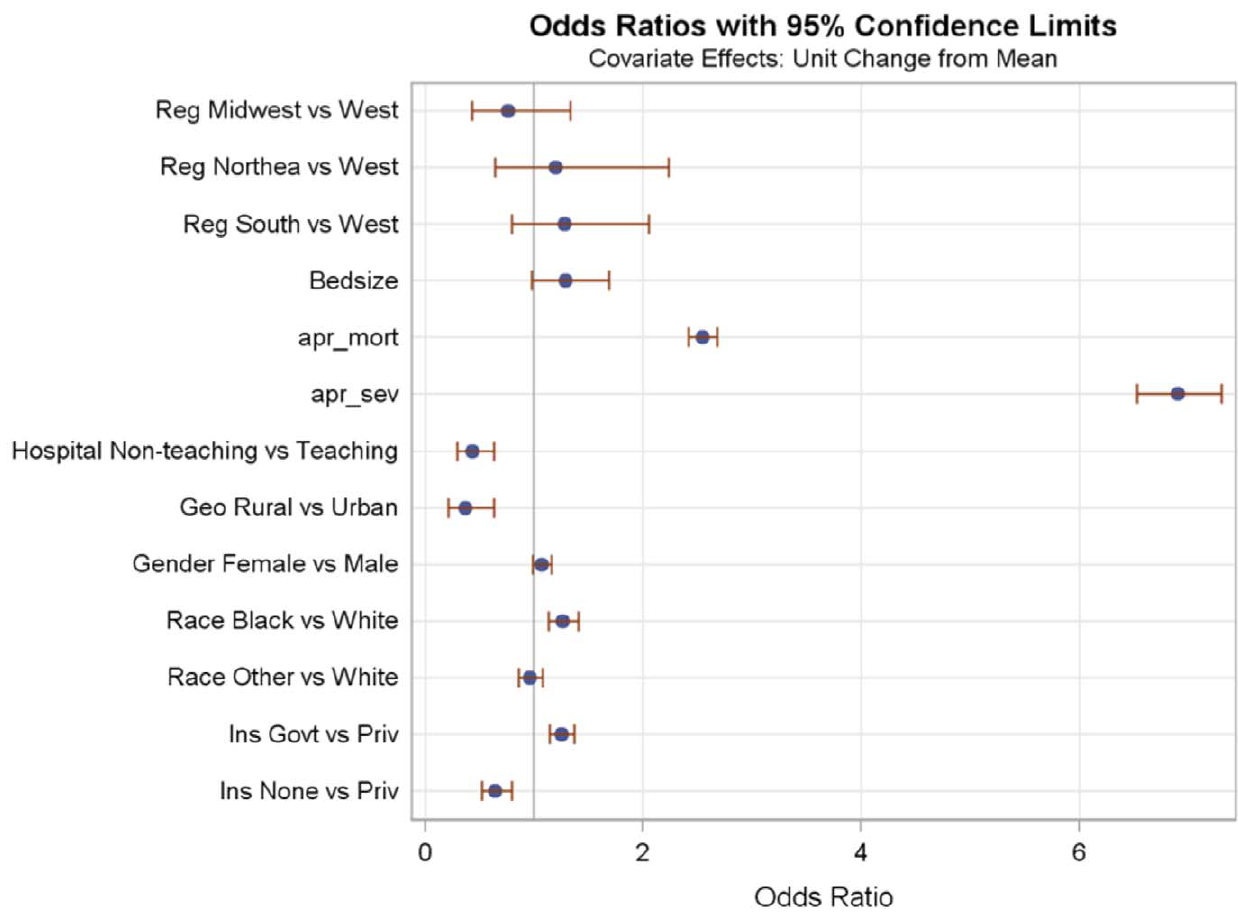
Figure 2. Odds Ratios for models in patients under 1 year of age ICD-9-CM group ‘‘Liveborn infants according to type of birth’’.